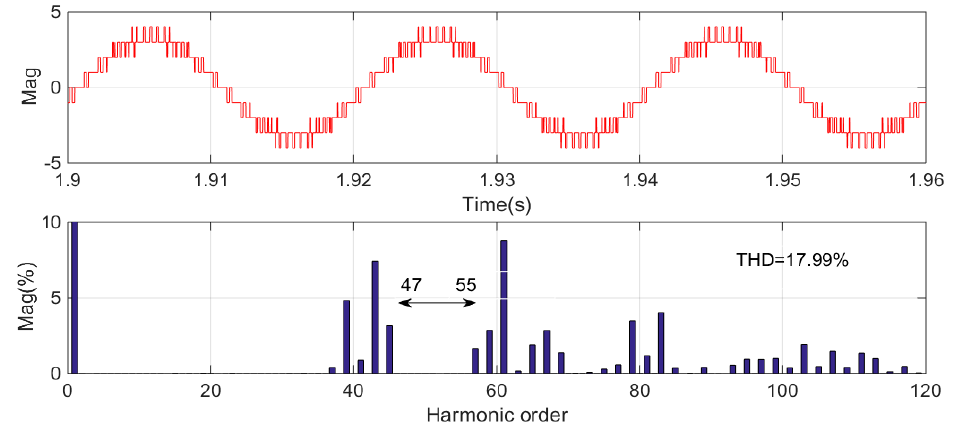
Figure 17. Waveform and Fourier analysis of four-dimensional 4QC synthesis pulse.